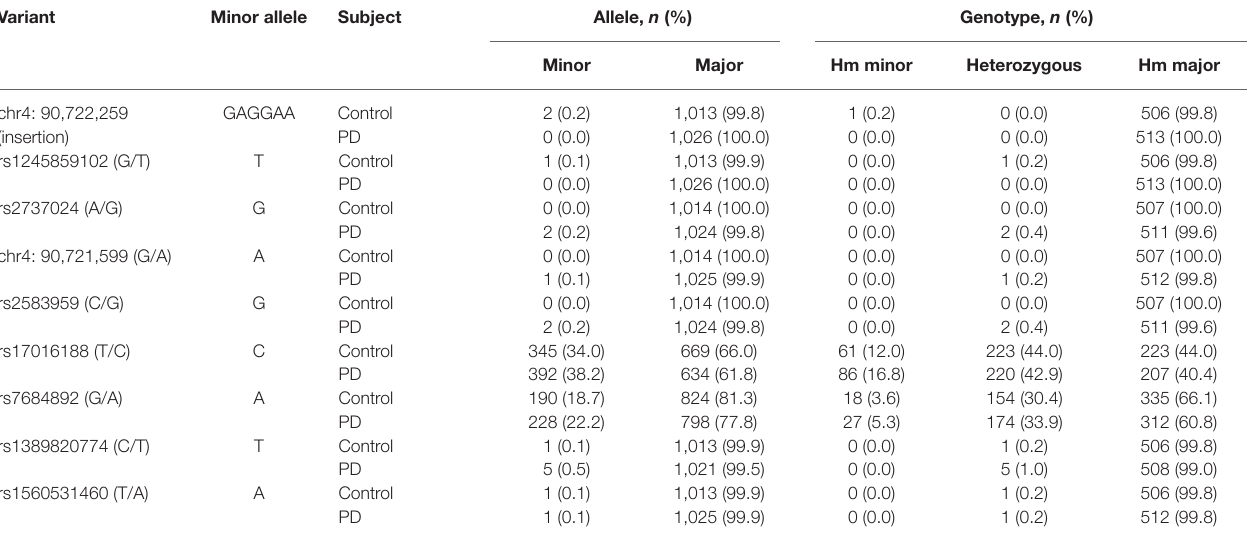
Hm, homozygous; PD, Parkinson’s disease.